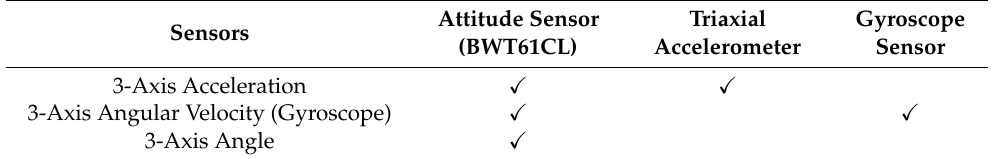
Attitude Sensor